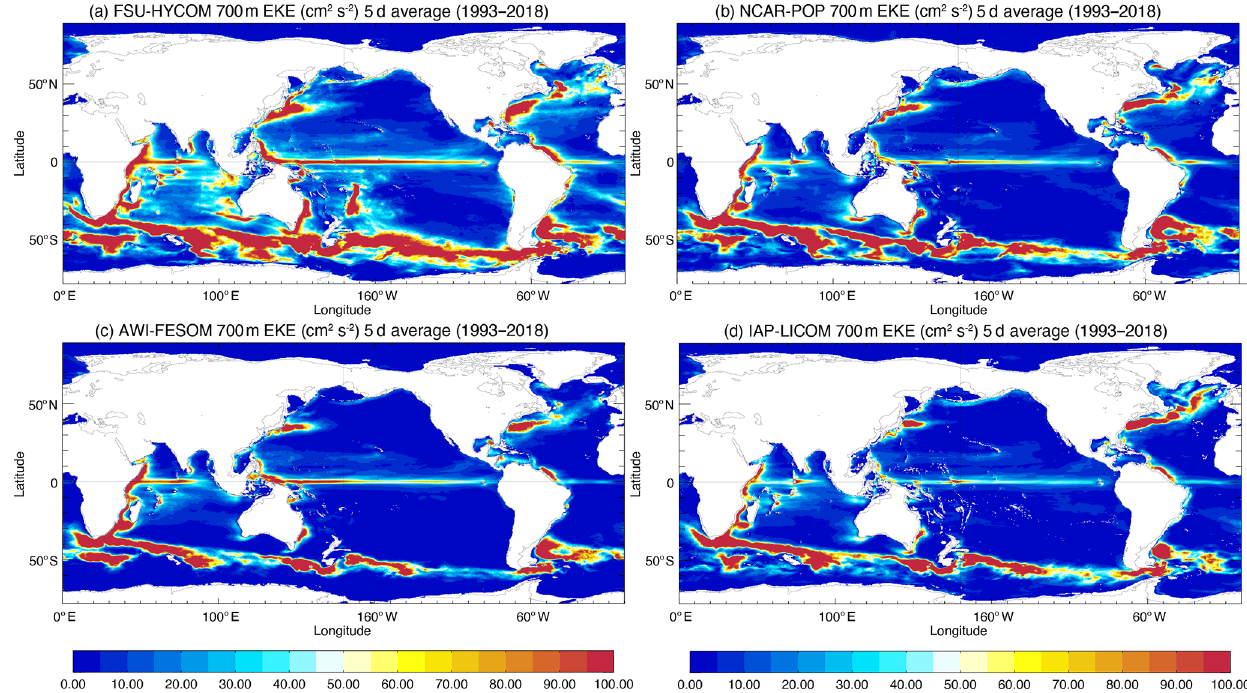
Figure 20. EKE at 700m calculated from 5d average fields in (a) FSU-HYCOM, (b) NCAR-POP, (c) AWI-FESOM, and (d) IAP-LICOM.